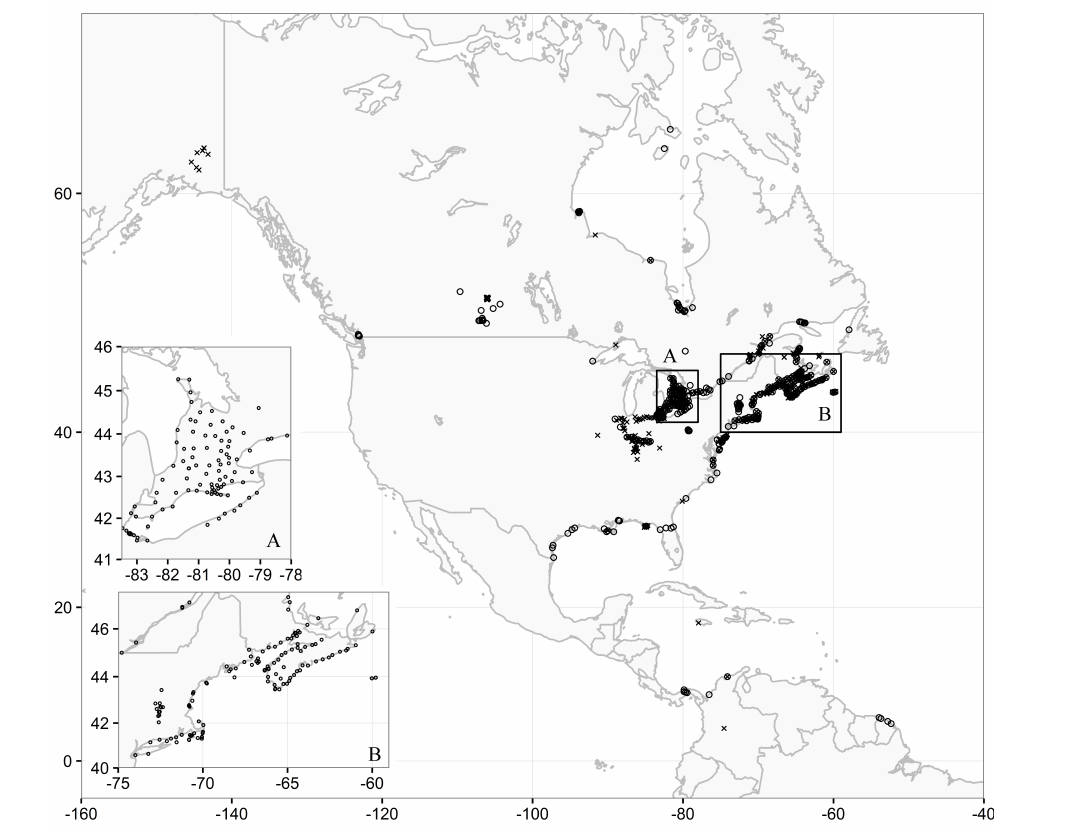
Fig. 1 . Locations of Motus receiving stations in the Western Hemisphere between 2014 and 2016. Stations deployed in Europe are not shown. Permanent (active through most of the year) stations are shown by open circles, while stations that were set up temporarily for research-specific needs are shown by ×. Insets show the location of towers in the grid array in Ontario (A), and the turnstile or "fence" style of array along the coast of northeastern North America (B), which has been used to detect tagged migrants as they depart over the ocean during migration, coming onto land after a flight, or flying down the